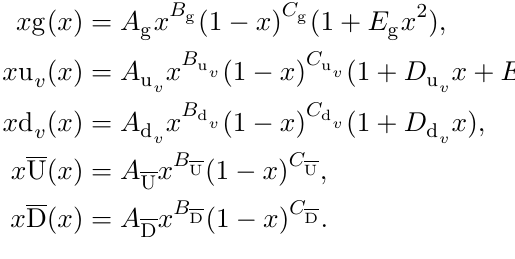
Figure 14 . The u -valence (upper left), d -valence (upper right), gluon (lower left), and sea quark (lower right) distributions, shown as a function of x at the scale µ NNLO fit using HERA DIS together with the CMS inclusive jet cross section at Contributions of fit, model, and parameterisation uncertainties for each PDF are shown. In the lower panels, the relative uncertainty contributions are